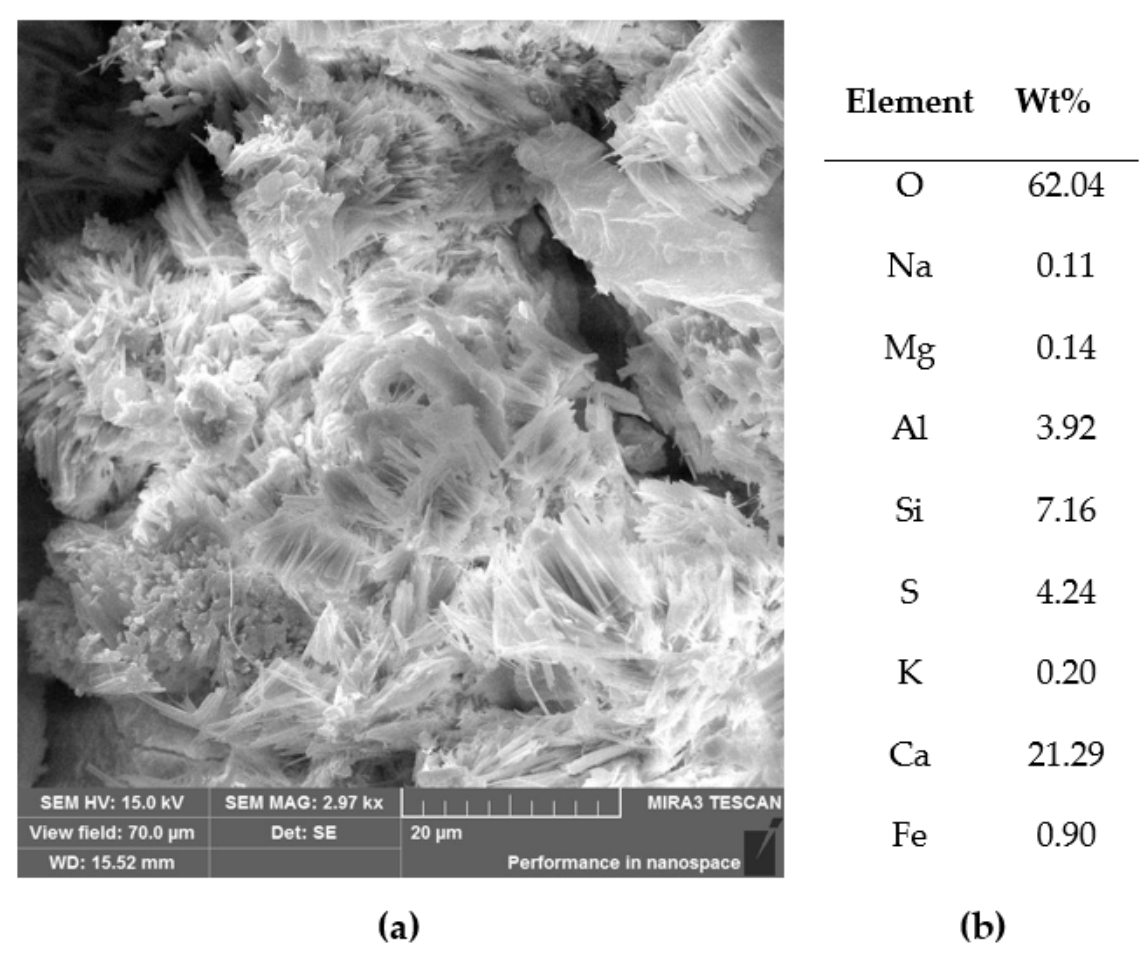
Figure 16. A crystalline form from inside a pore of the concrete, specimen 4: ( a ) SEM-SE image and ( b ) elemental content of the entire shown area.